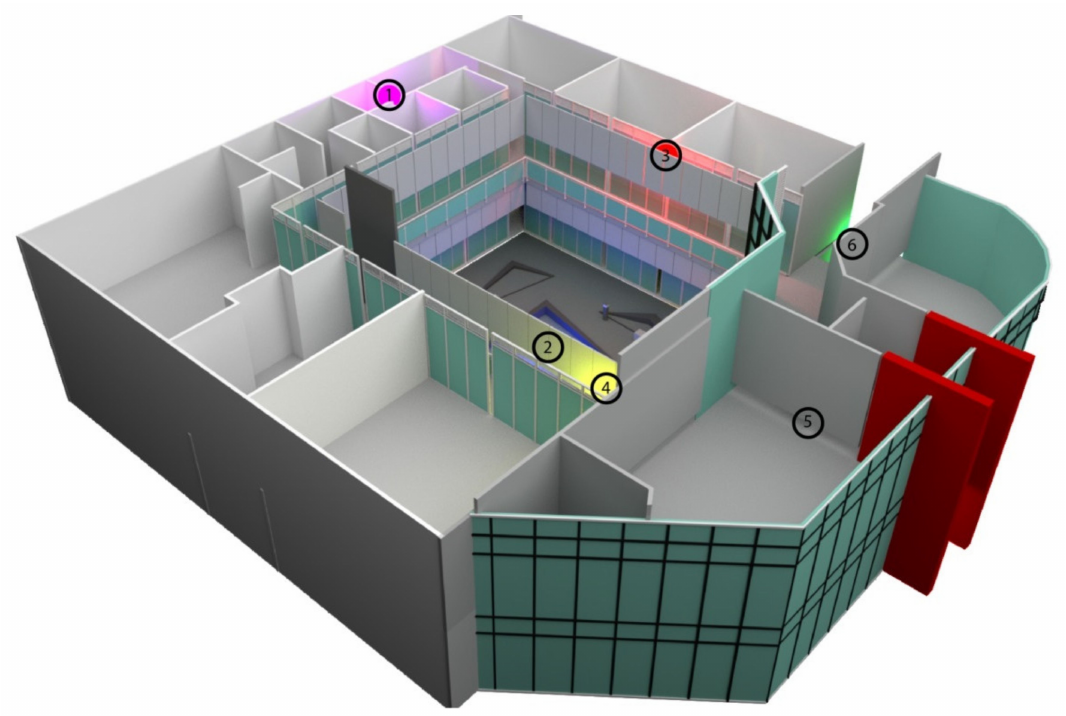
Figure 5. Location of the sensors in the Engineering building of the campus.